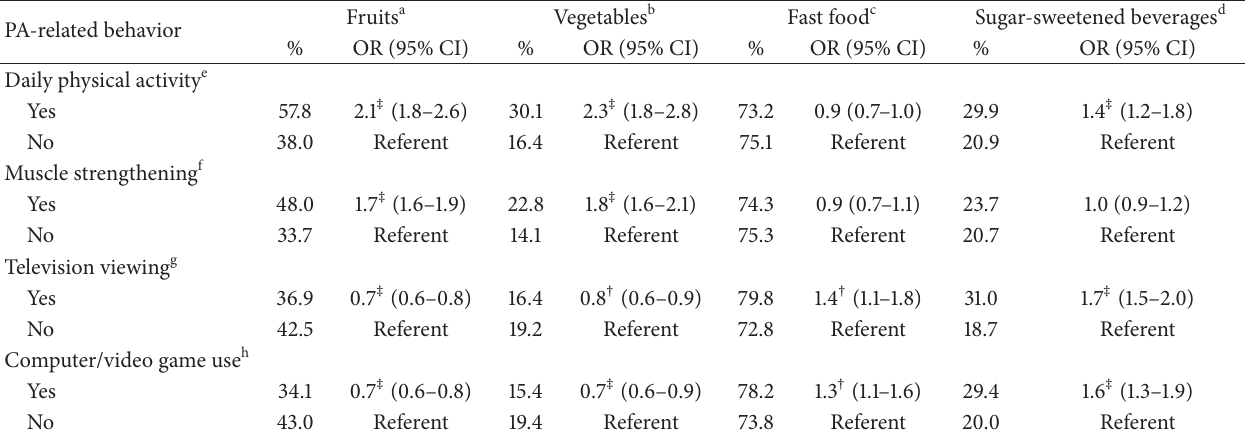
Table 3: Prevalence (%) and adjusted odds ratios (ORs) for dietary behaviors by physical activity-related behaviors, among US high school